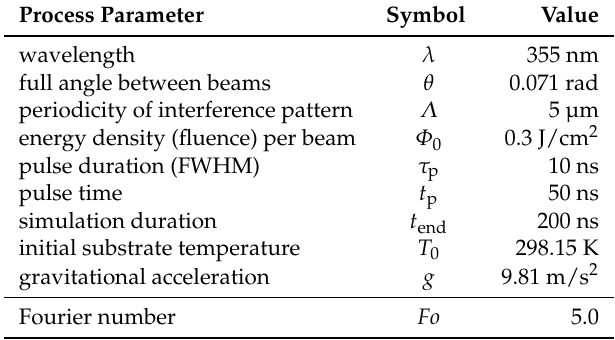
Table 2. Process parameters of single-pulse direct laser interference patterning (DLIP) of metallic substrate.